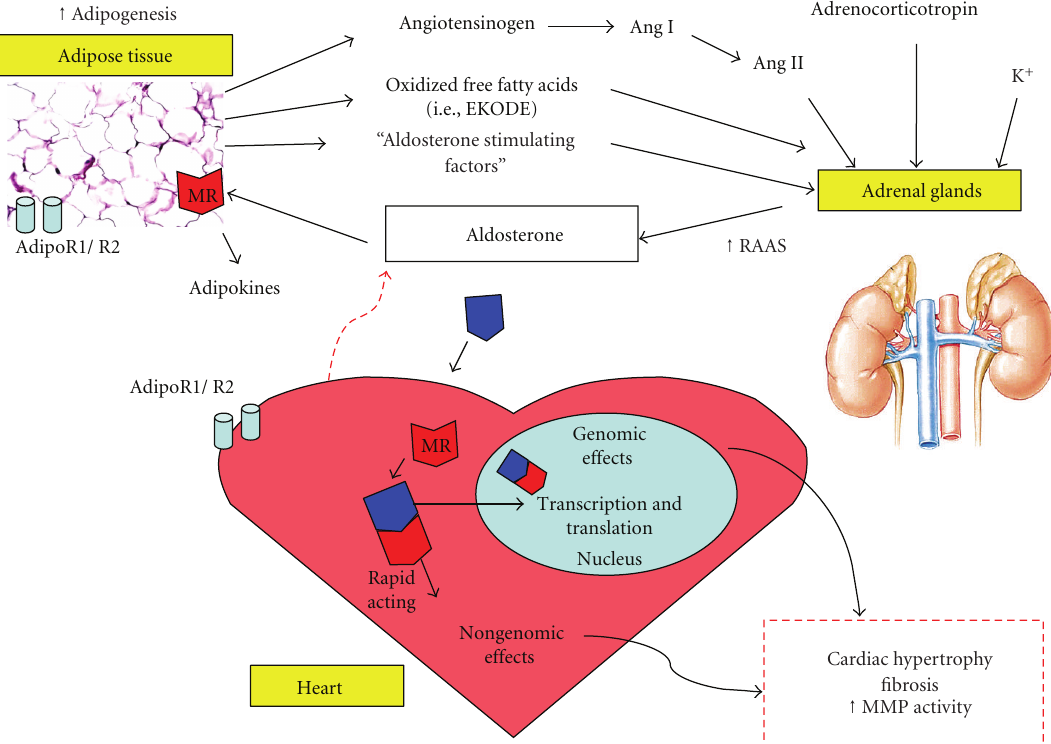
Figure 1: Proposed schematic representation of the interplay between adipose tissue, adrenal aldosterone production, and cardiac remodeling in the metabolic syndrome. Aldosterone production is increased in response to molecular factors including angiotensin, K + , and adrenocorticotropin, as well as a number of adipocyte-derived “aldosterone-stimulating factors.” Aldosterone mediates both genomic and nongenomic e ff ects on the heart through its interaction with the mineralocorticoid receptor (MR), which may ultimately result in adverse cardiac remodeling. In addition, aldosterone can target adipocyte-specific MRs which may enhance adipogenesis. Furthermore, elevated aldosterone binding to adipocyte MRs may modulate adiponectin production. The presence of adiponectin receptors (AdipoR1 and AdipoR2) on the cardiomyocyte and that both aldosterone and adiponectin are synthesized in the failing human heart suggest a potential for crosstalk between adiponectin and aldosterone in pathological